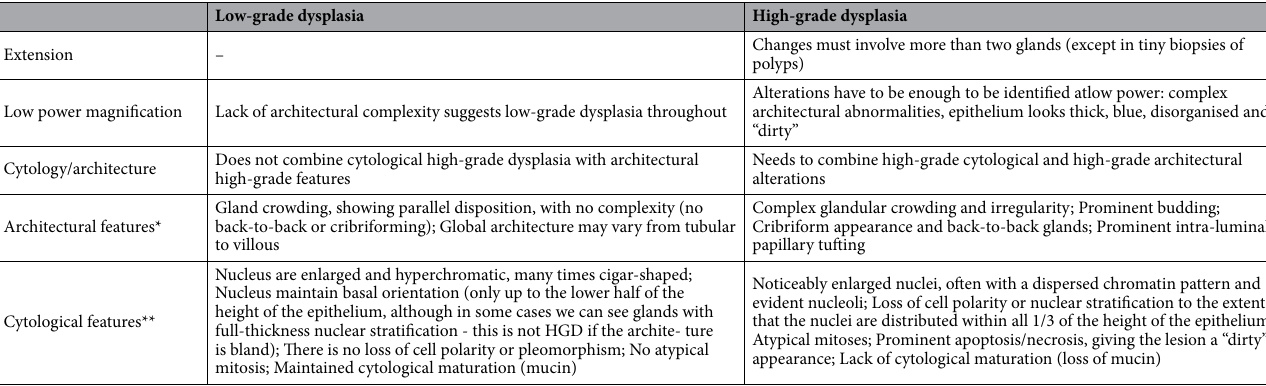
Table 1. Colorectal low- and high-grade dysplasia characterisation. *Architectural features: gland morphology and placement; **Cytological features: cell level